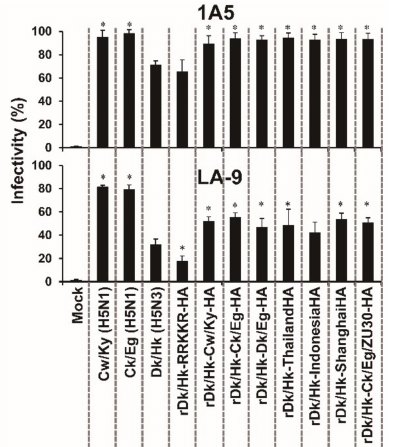
Figure 5. Susceptibility of human small airway epithelial and tracheal epithelial cell clones to infection by recombinant H5N3 viruses harboring the H5N1 HA gene. Human SAEC-T clone 1A5 and